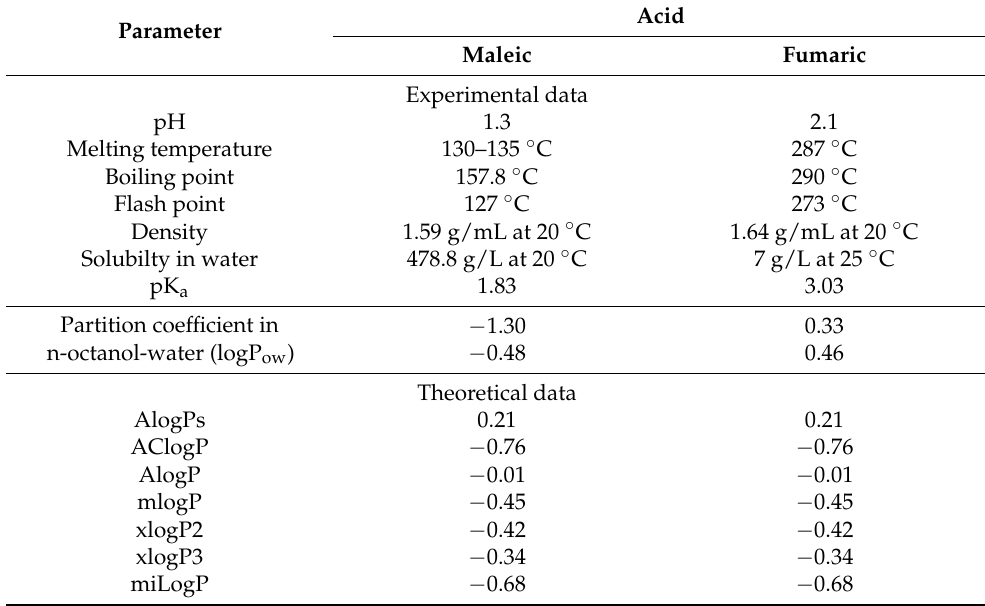
Table 1. Experimental and theoretical physicochemical properties of maleic and fumaric